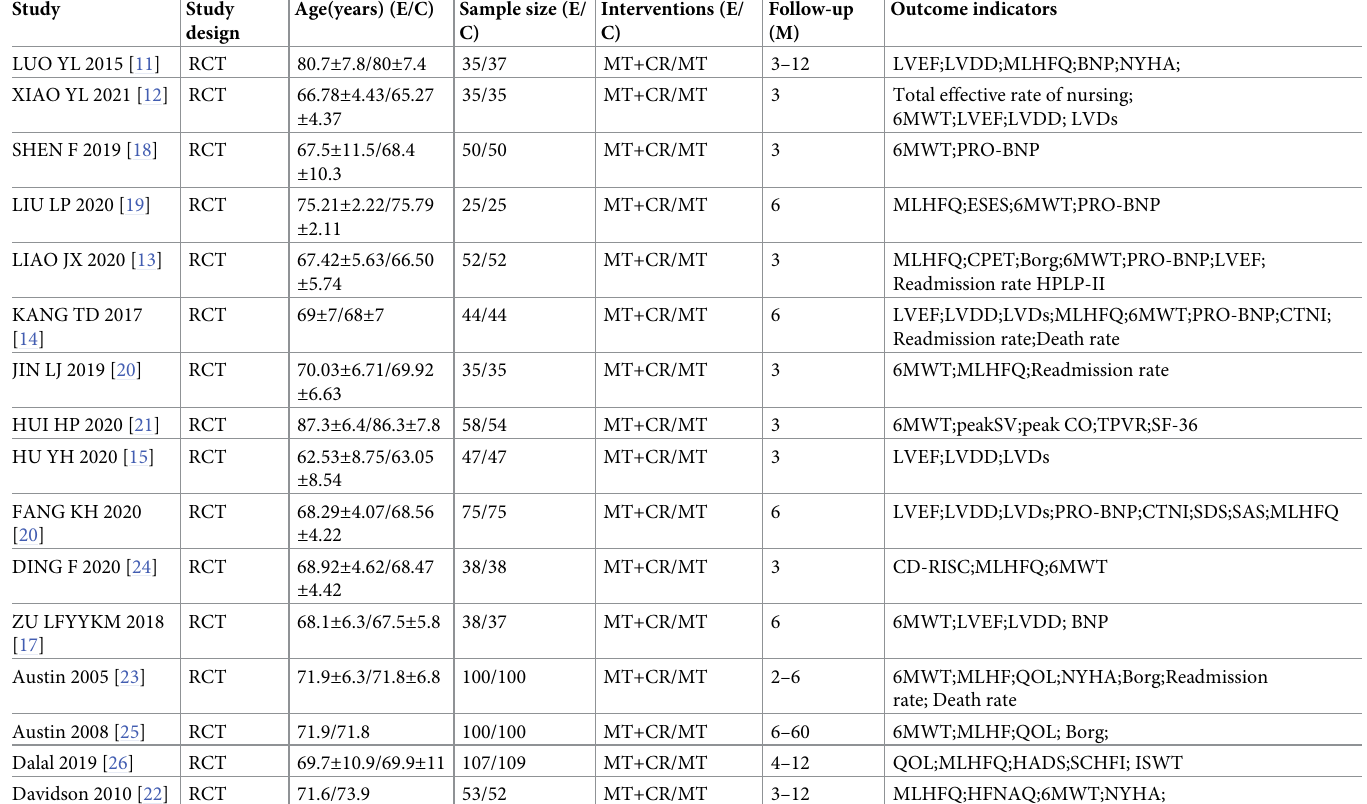
Table 1. Outcome